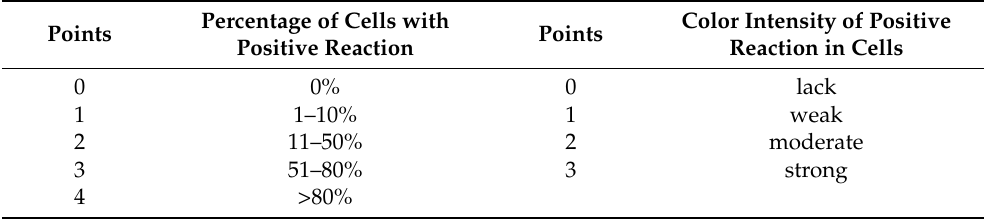
Table 1. The semiquantitative scale assessing the irisin and MT-I/II expression in control tissues of the larynx, BLs, and LSCC according to Remmele and Stegner (IRS) [40]. Modified table according to Nowinska